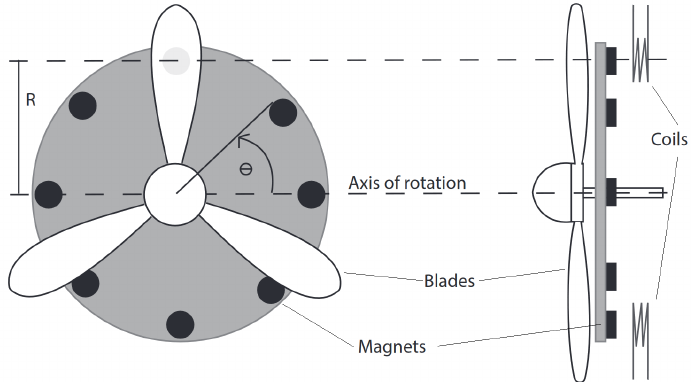
Figure 2. Example of a rotational energy harvester that has the magnets rotating at a radius similar to that of the fan blades [22,30]. Here, although the magnets are not attached directly to the blades, they still have a significantly large mass spinning at a relatively fast velocity and at a large radius from the axis of